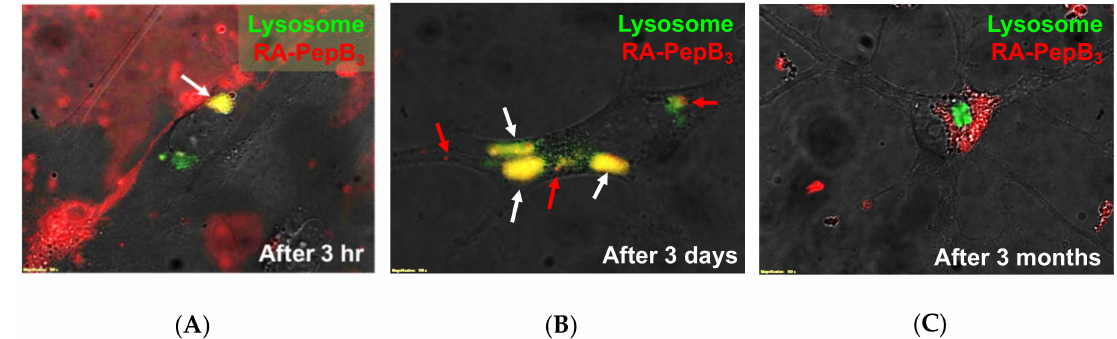
Figure 8. Live cell microscopy results for RA-PepB 3 treated RVM Cells. RA-PepB 3 was found localized to the lysosomes after ( A ) 3 h of treatment at 1 µ M (white arrow, yellow region); ( B ) 3 days after initial treatment, RA-PepB 3 was mostly localized to the lysosomes (white arrows, yellow region) but some have escaped into the cytosol (red arrows); and ( C ) after 3 months, the red-dye-labeled molecules have escaped the